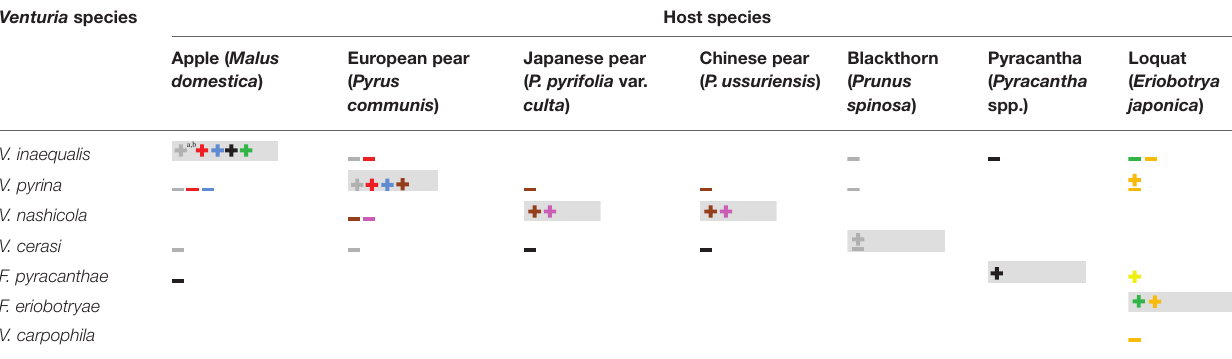
TABLE 2 | Results of cross inoculations of Venturia spp. on different Rosaceous hosts. Venturia